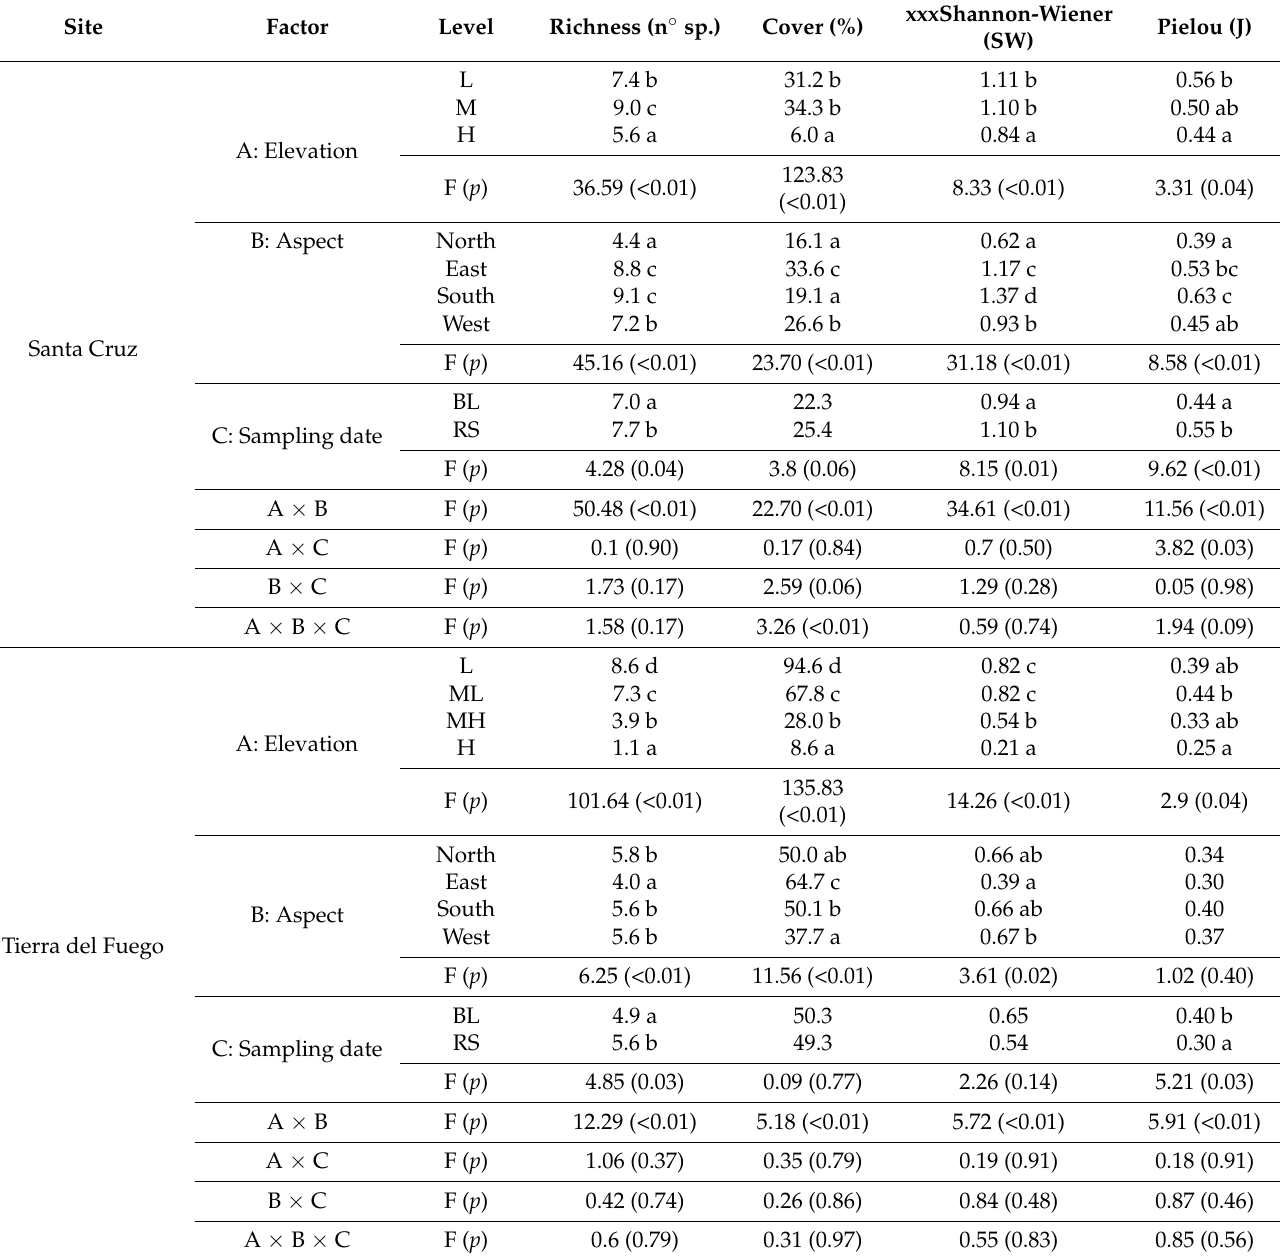
F ( p ) = Fisher test, with significance level in parentheses. Different letters in a column indicate significant differences ( p < 0.05) by the Tukey